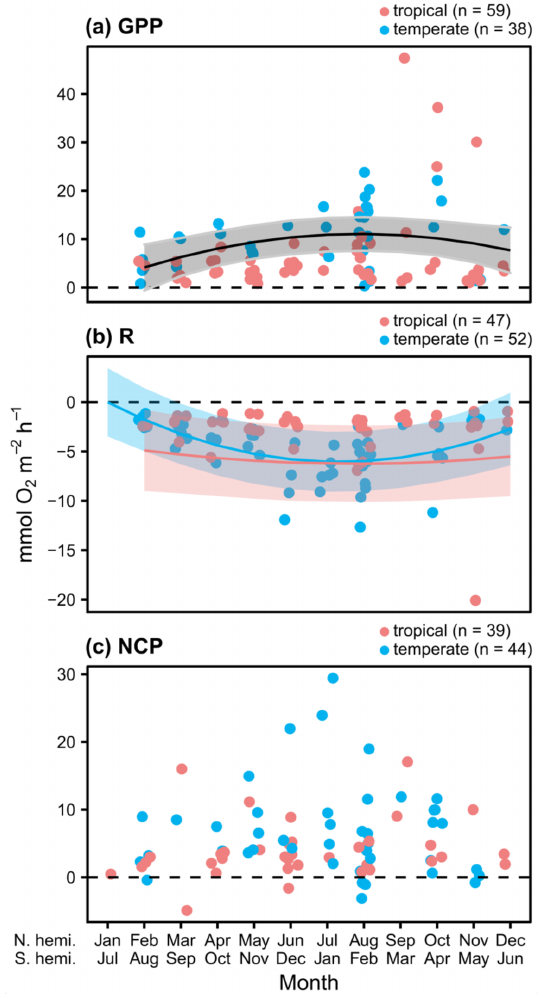
Figure 2. Hourly rates for O 2 fluxes (mmolm − 2 h − 1 ) associated with seagrass communities as a function of time, with GPP mea- surements taken during peak sunlight hours ( ∼ 10:00 to 14:00LT). Studies performed in temperate versus tropical ecosystems are illus- trated by color (blue is temperate, red is tropical), and significance ( P < 0 . 05) is denoted by a fit line with a quadratic term and 95% CI. The colors of the lines denote significant differences between tropical and temperate systems in GPP and R , while a black line denotes a significant relationship but no difference between temper- ate and tropical